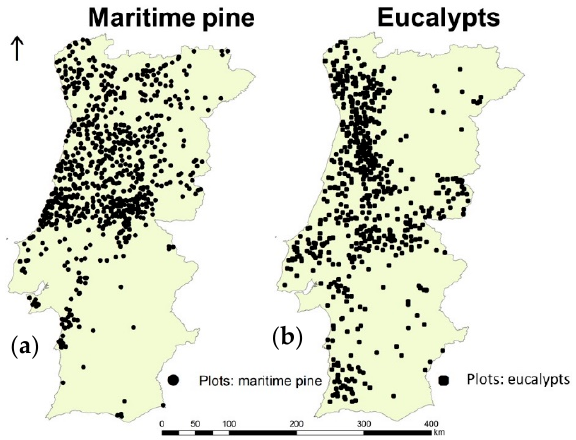
Figure 2. National Forest Inventory data (1990–1994): ( a ) Plots in pure maritime pine stands ( n = 744); ( b ) Plots in pure eucalypts stands ( n = 615). Table 2. Summary statistics—Stands characteristics for the NFI4 plots (1990–1994). Variable Units Min. Max.